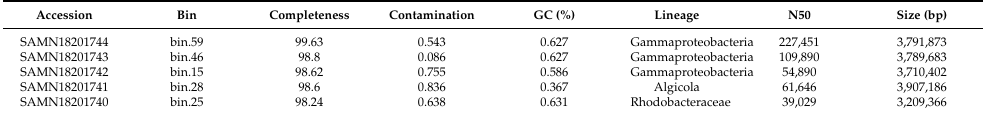
Table 3. General characteristics of five high-quality reconstructed genomes of